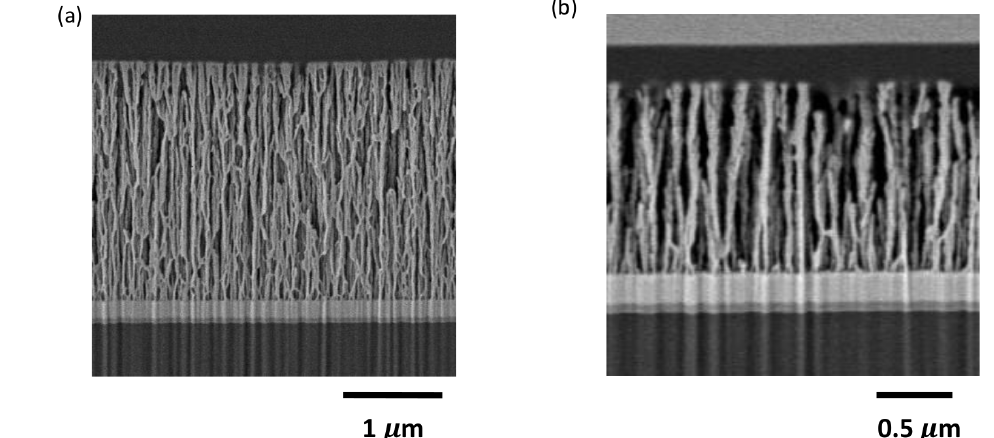
Figure 3. Representative xy slices from the SE image stacks for (a) Ta80 and (b) Ta85.